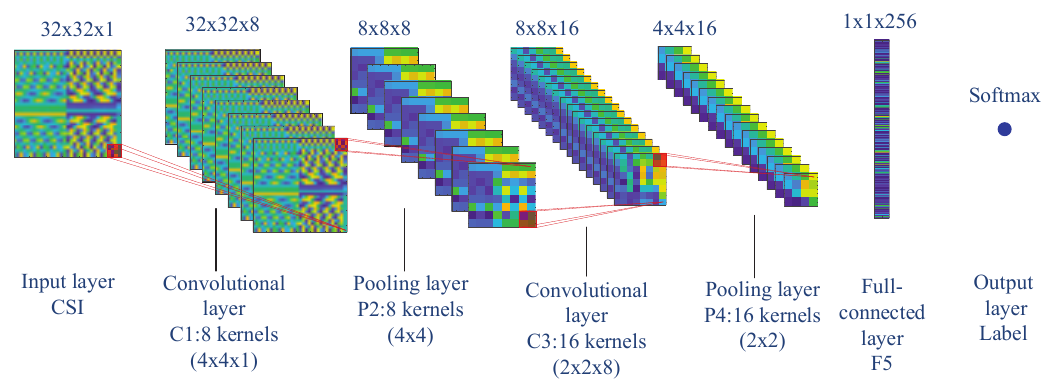
Figure 2. The convolutional neural network. CSI, channel state